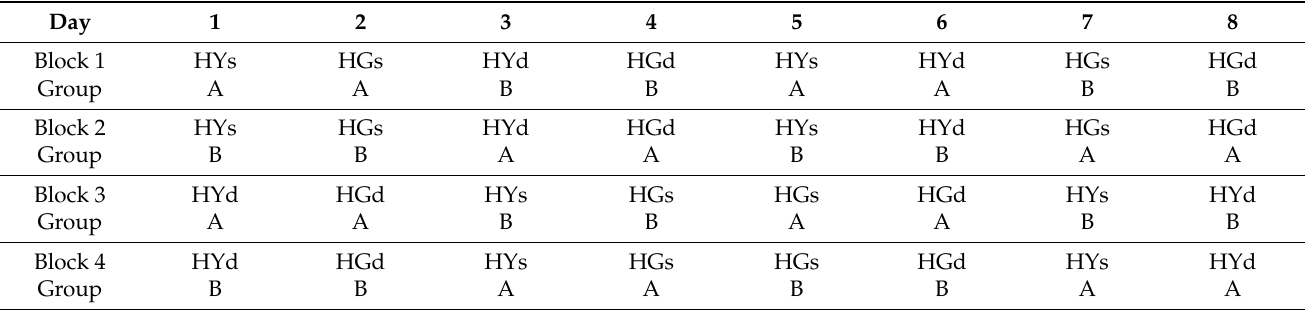
Table 2. Organisation of treatment groups by block and day after randomly assigning horses (n = 10) to either Group A or B in a Latin Square Design set